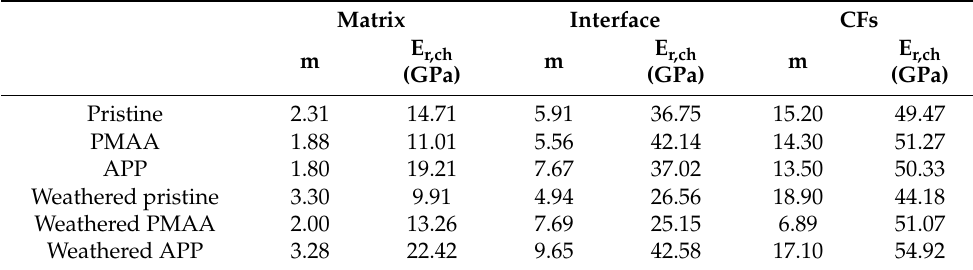
Table 1. Weibull modulus m for the tested CFRPs for E r .